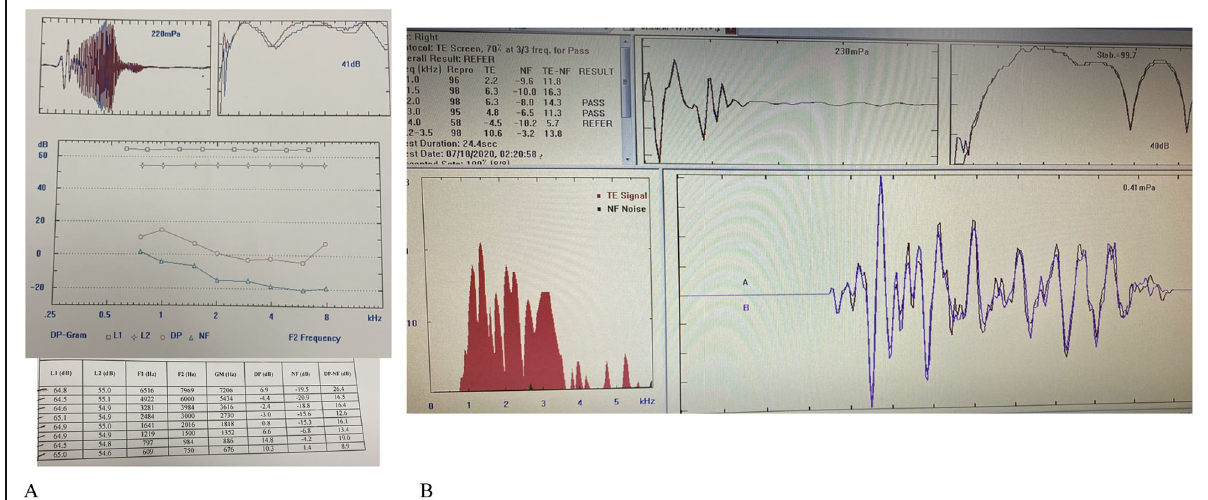
Fig. 2 a DPOAE in one of the study group patients. b TEOAE in one of the study group